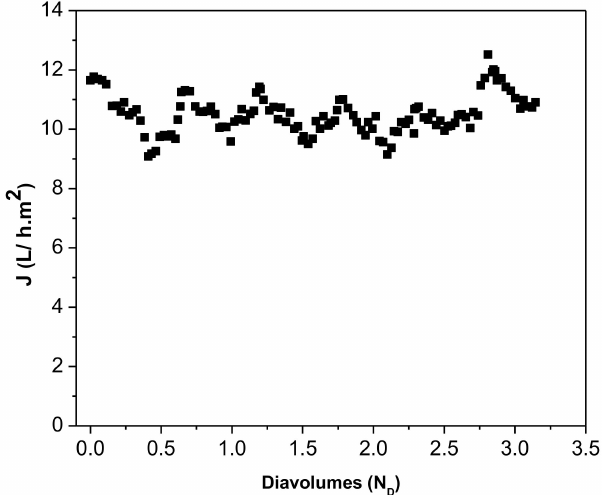
Figure 3. Permeate flux, J , obtained during diafiltration of the SW30 concentrate of the synthetic tannery effluent, using the cs-PES MF022 membrane at an applied pressure of 20 bar. The efficiency of the diafiltration process was evaluated based on the membrane ability to selectively remove Cr(III) (the target compound) in reference to the other ionic species present in the SW30 concentrate, namely Na, K, Ca, Mg, S, Cl − containing ionic species, and NH 4+